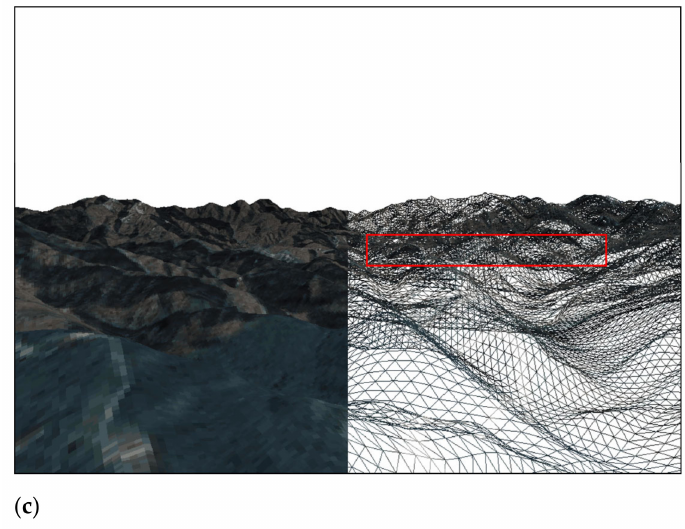
Figure 15. Frame images of three methods. ( a ) shows a frame image of Method A. ( b ) shows a frame image of Method B. ( c ) shows a frame image of Method C.